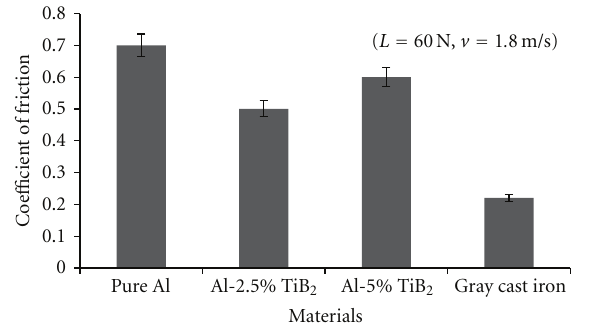
Figure 13: E ff ect of ultimate tensile strength on wear rate of composites.